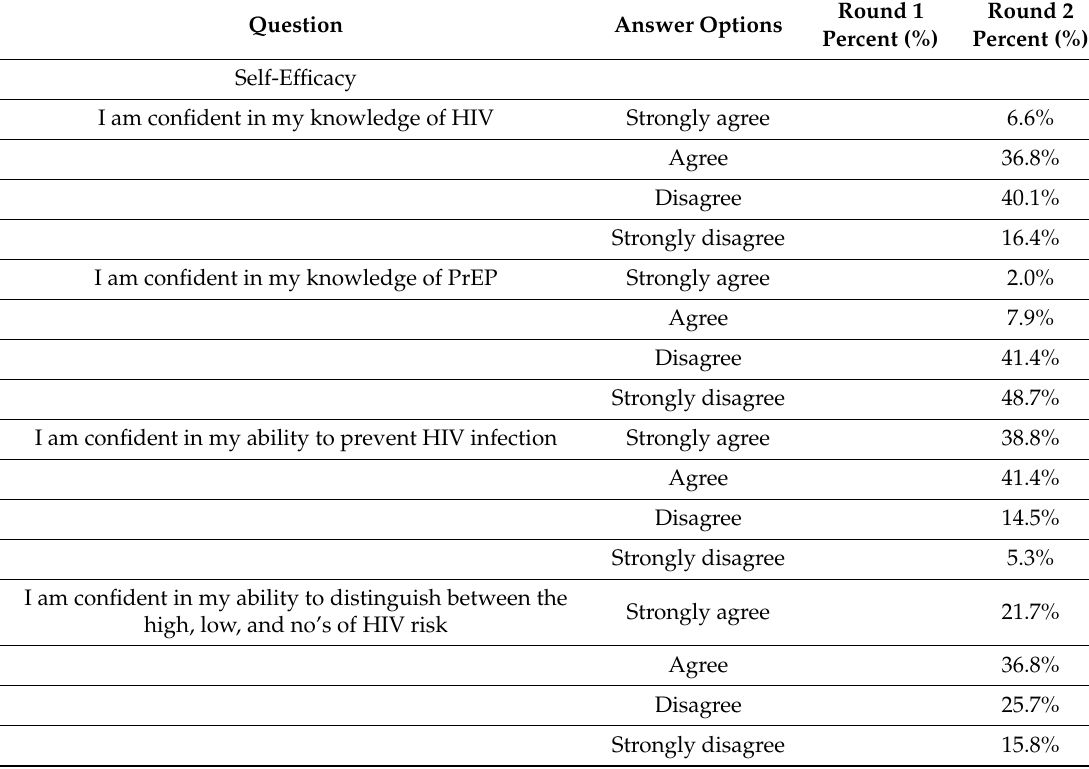
Table 5. HIV self-e ffi cacy among college students (n =